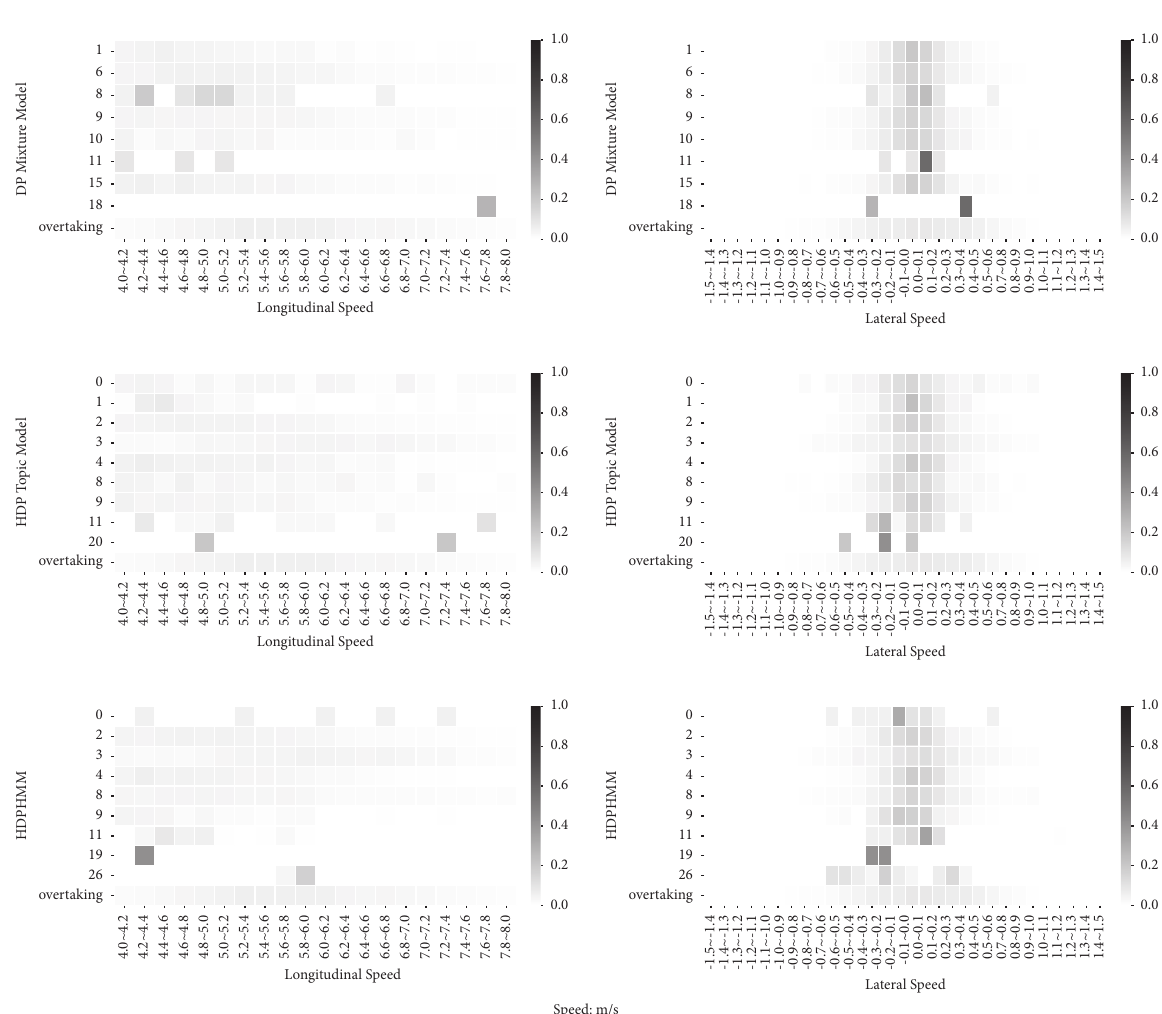
Figure 11: Speed’s heat map of different clusters in different